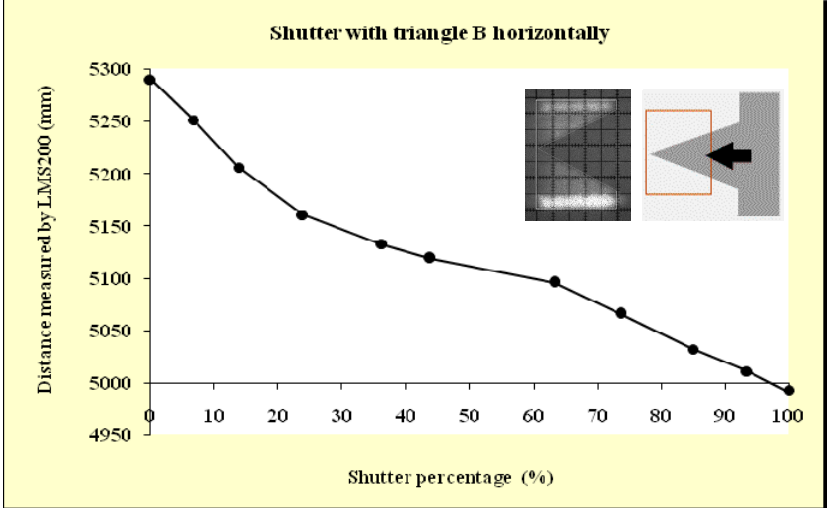
Figure 13. Graphic representation of the evolution of the distance measurement given by the sensor when the laser beam (90°) was incrementally blocked (from right to left) using the triangular shaped template B at a distance of 5 m from the sensor and the unblocked part of the beam was captured by the grid template at a distance of 5.3 m.